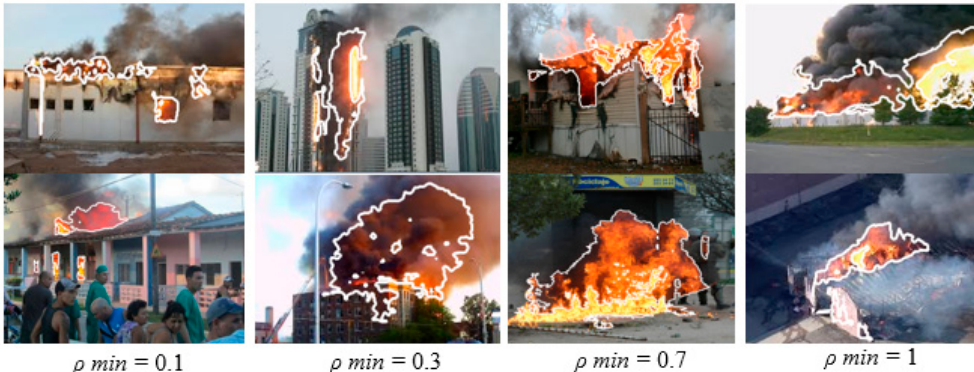
Figure 9. Fire detection with FFDI in different scenes.